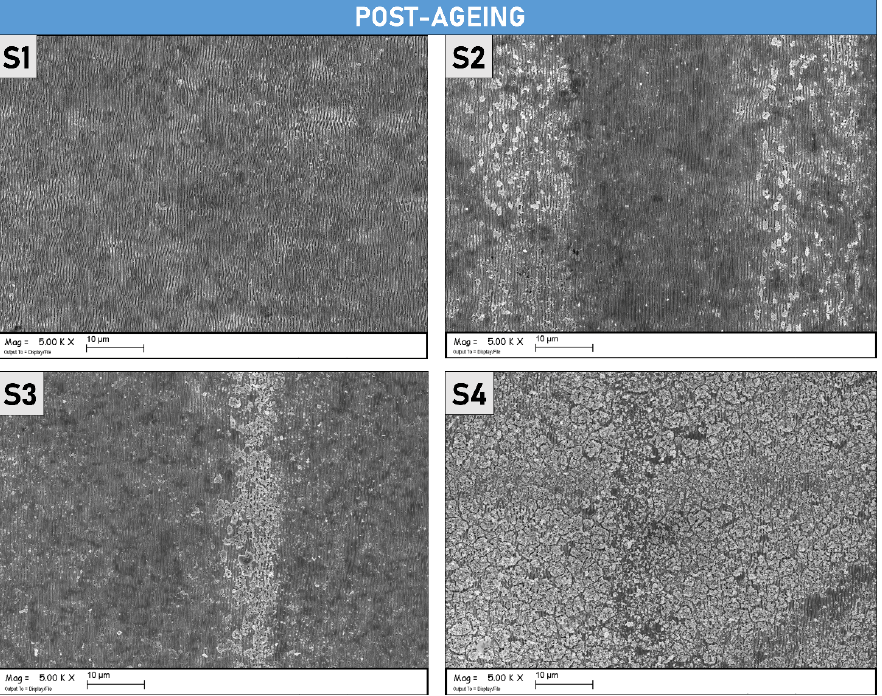
Figure 11. SEM micrographs acquired at lower magnification than Figure 10 (5 k×) of the four different Mo samples after thermal ageing.